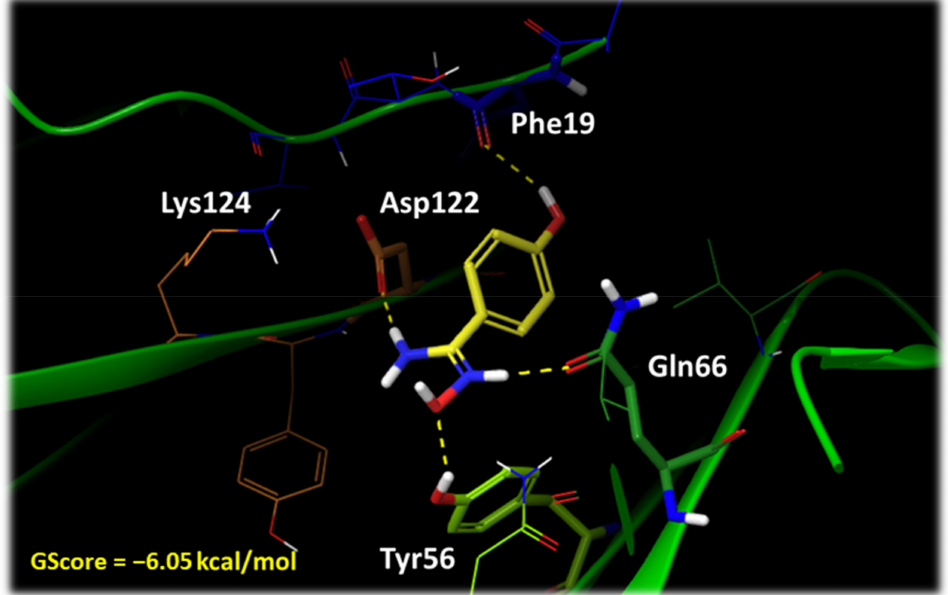
Figure 7. Binding mode of VIS1201 ( 17 ; yellow carbon atoms). Residues of PD-L1 chain C are shown with orange carbon atoms (Asp122, Lys124) and blue carbon atoms (Phe19). Residues of PD-L1 chain D are shown with green carbon atoms (Tyr56, Gln66). Hydrogen bonds are shown as yellow dashed